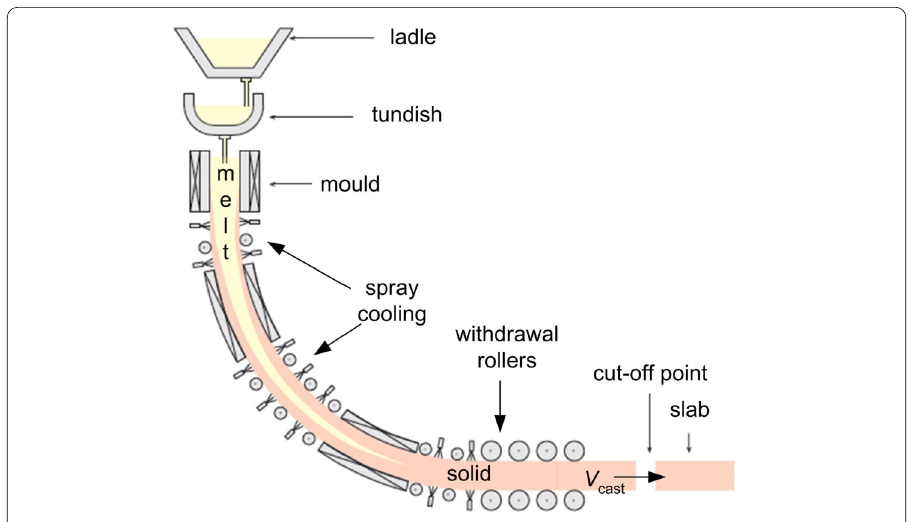
Figure 1 Schematic of the continuous casting process for steel. Melt passes from a ladle to a tundish and then down through a cooled mould region where solidification commences on the mould walls. The partially solidified steel passes through regions of spray cooling and withdrawal rollers, by which point complete solidification has occurred. Throughout, the solidified steel is pulled with a constant speed, V cast